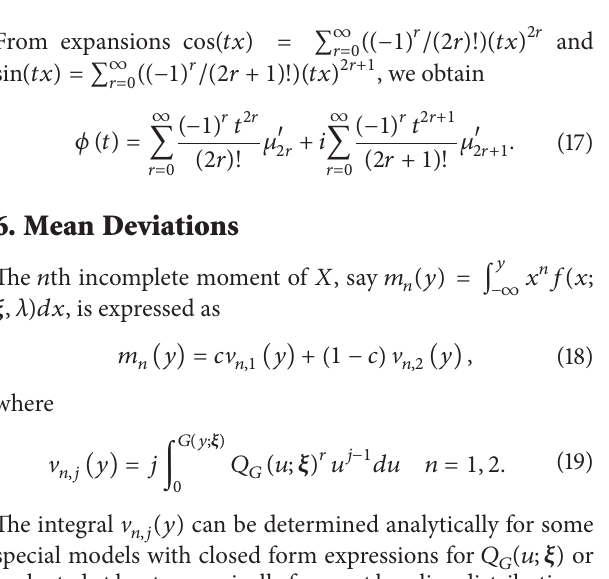
Algorithm 1: Random number generator for the TG distribution.